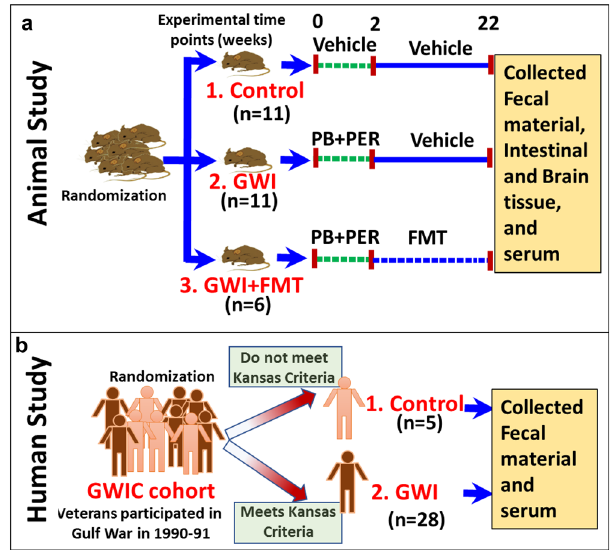
Fig. 8 A schematic representation of the experimental